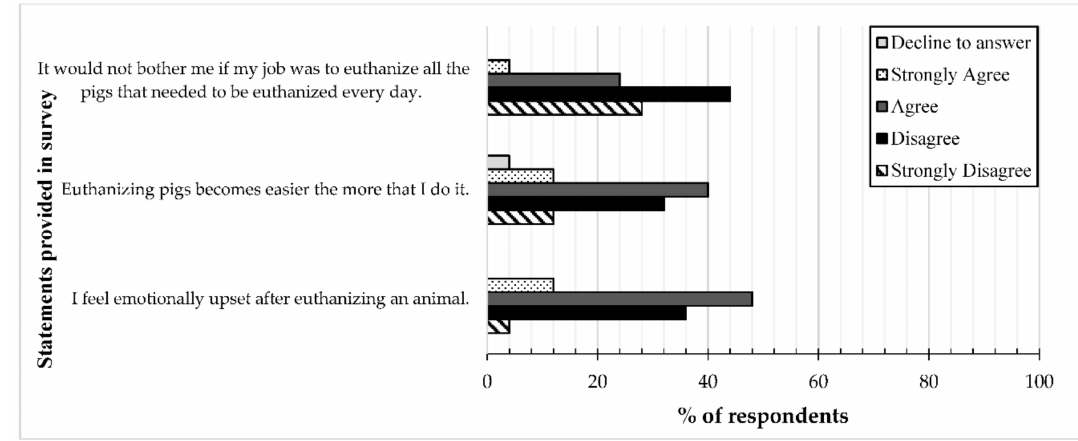
Figure 4. Respondents ( n = 25) were asked to indicate their level of agreement with various statements related to perceptions about euthanasia. The options available to choose from were: Decline to answer, Strongly Agree, Agree, Disagree, and Strongly